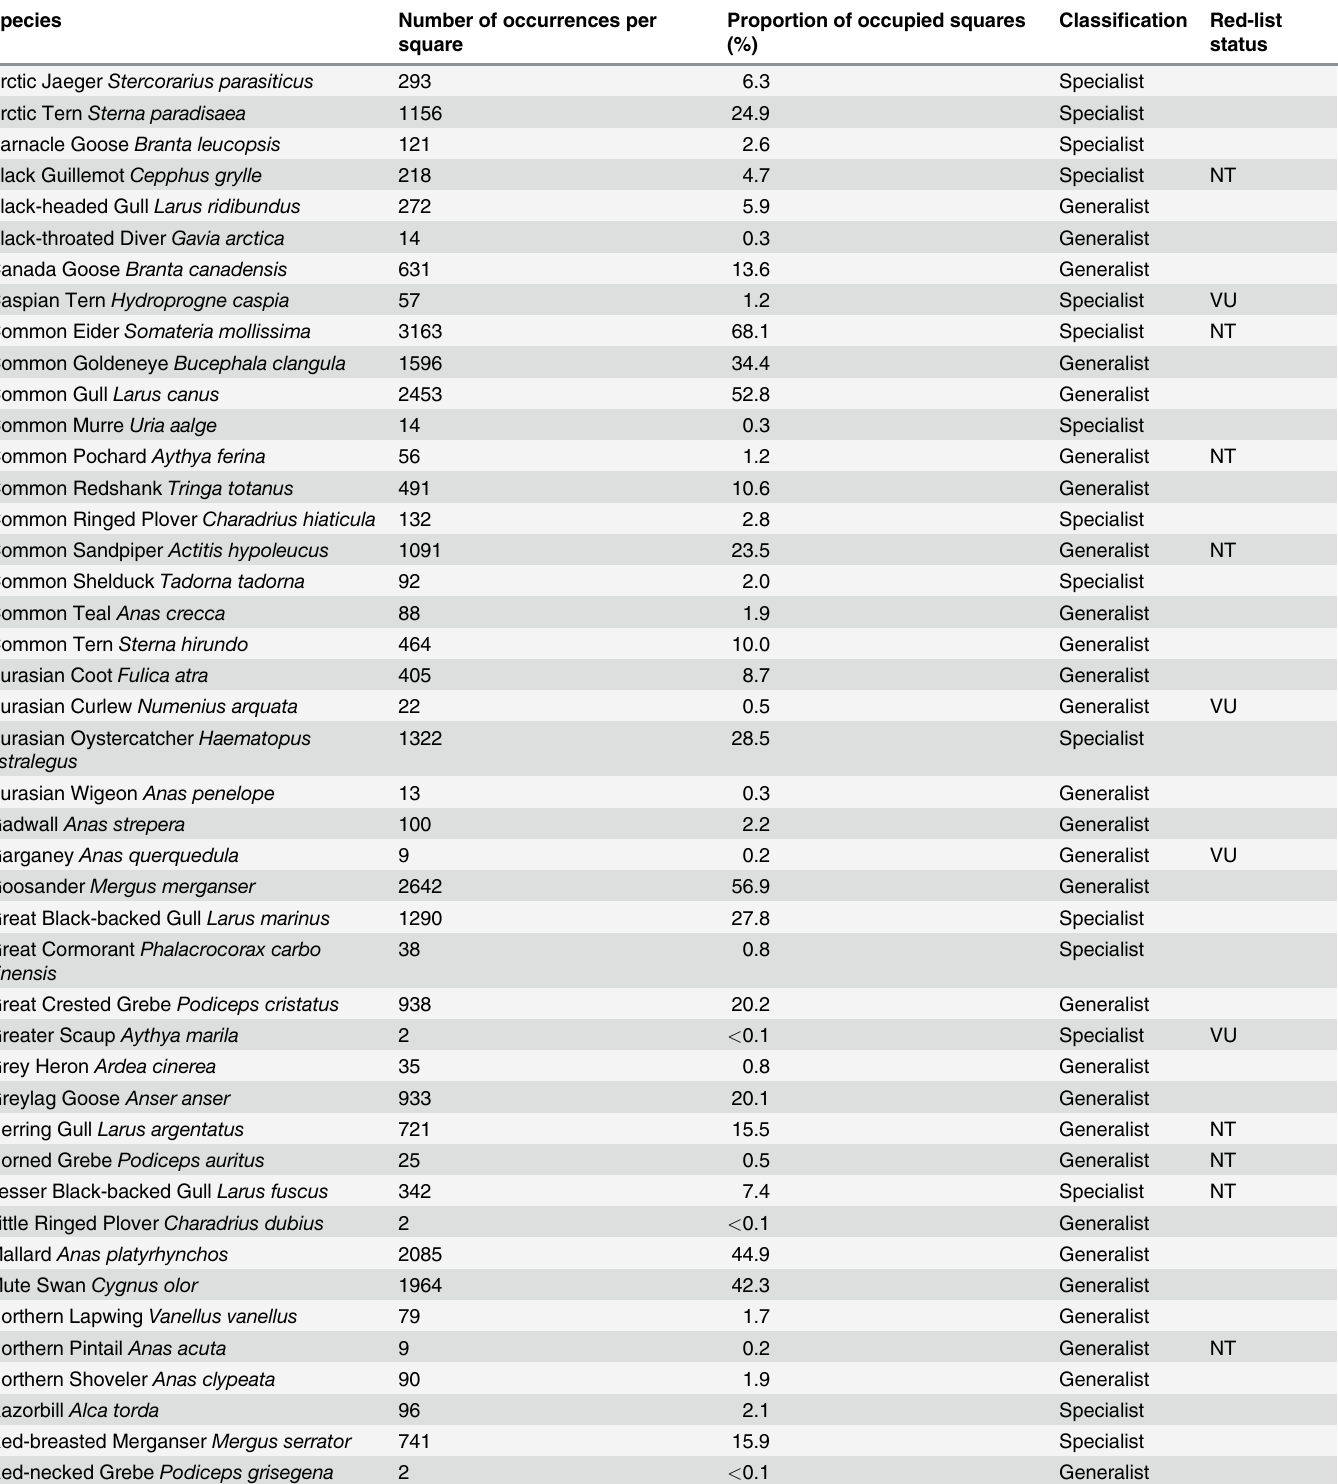
Table 1. Occurrence frequencies and classi fi cations of the studied coastal breeding bird species.